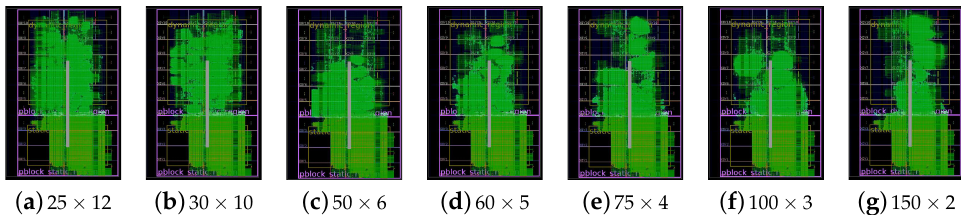
Figure 9. Device layout according to various combinations of parallel processing techniques (AP × MCU).